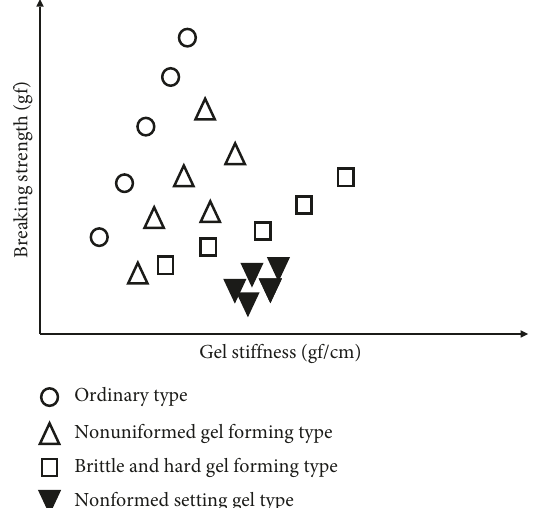
Figure 1: Model of GS versus BS relationship diagram. ○ , △ , □ , and ▼ indicate various types of